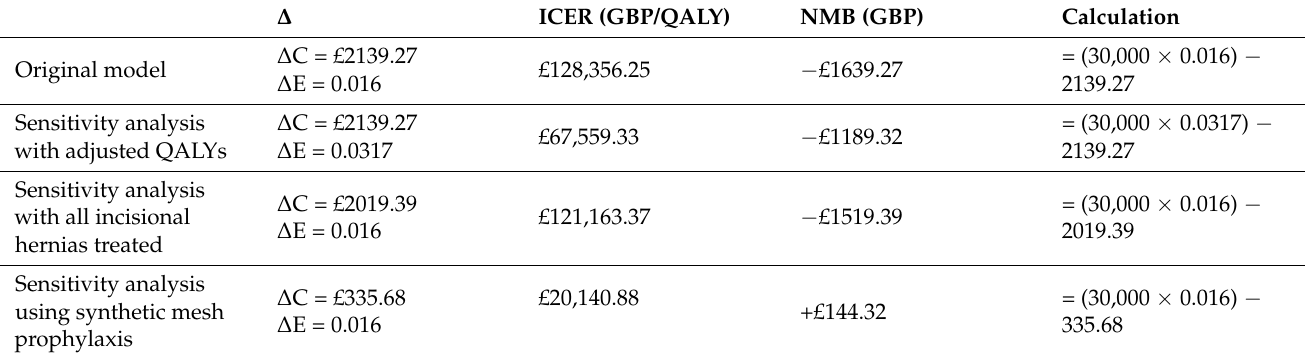
Table A9. NMB * calculations for the original model and the two sensitivity analyses.